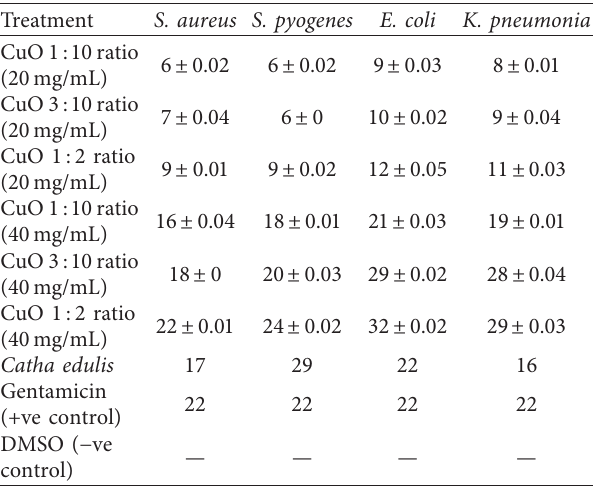
Table 1: Antibacterial activity of CuO NPs on selected pathogenic bacterial strains.